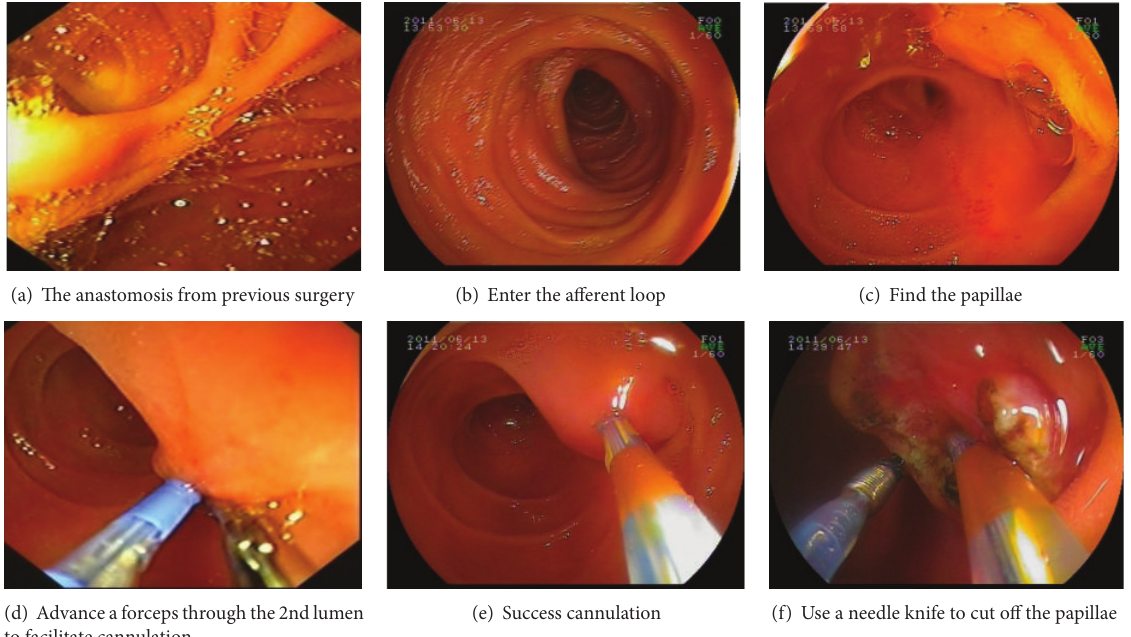
Figure 1: Images of the key procedures using a double-lumen forward-viewing endoscope for ERCP with prior Billroth II